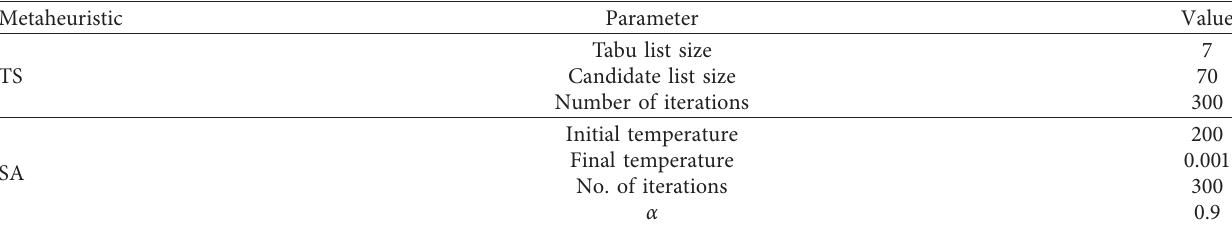
Table 9: Parameters setting for TS and SA.